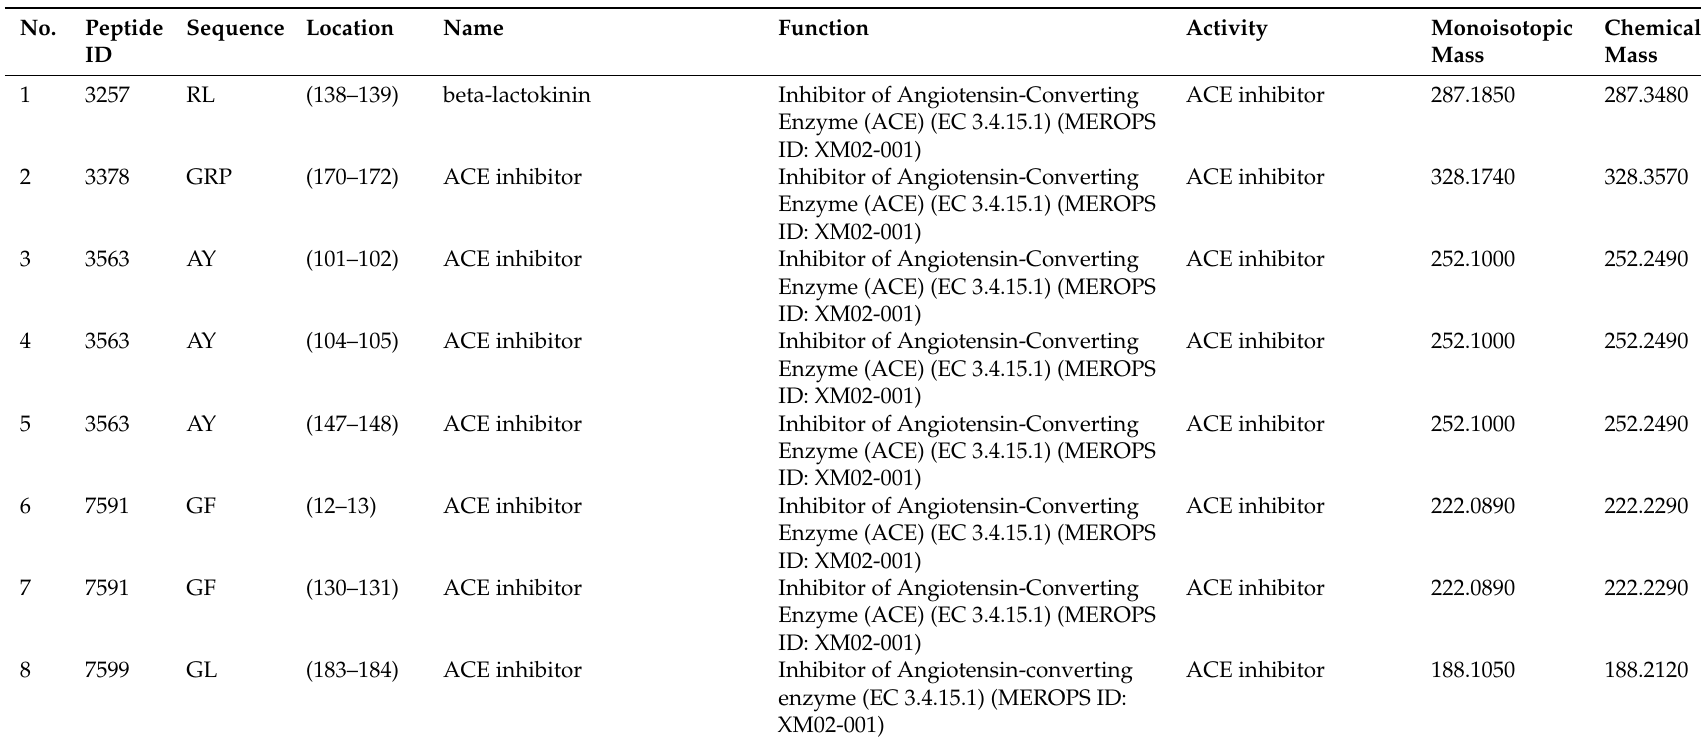
Table A7. Bioactive peptides from RubisCO of Halophila stipulacea . In silico enzymatic cleavage was carried out by using proteinase